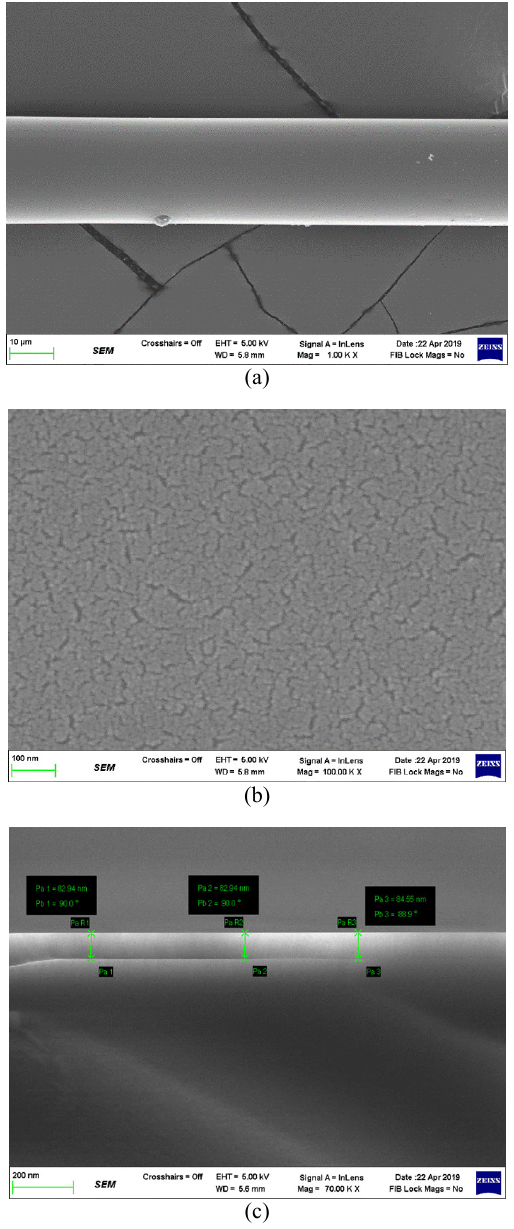
Fig. 5 FESEM: (a) top view image of the tapered fiber coated with the GO/PVA nanocomposite layer, (b) magnified top view image of the tapered fiber coated with the GO/PVA nanocomposite layer, and (c) cross-sectional view of the tapered fiber coated with the GO/PVA nanocomposite layer.